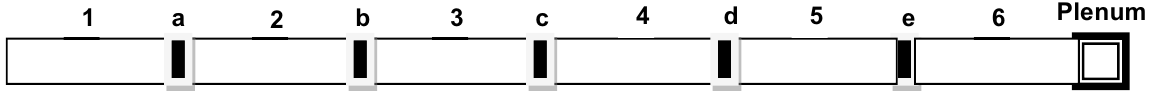
Fig. 1. Yankee Rowe fuel rod assumed discretization based on the literature data